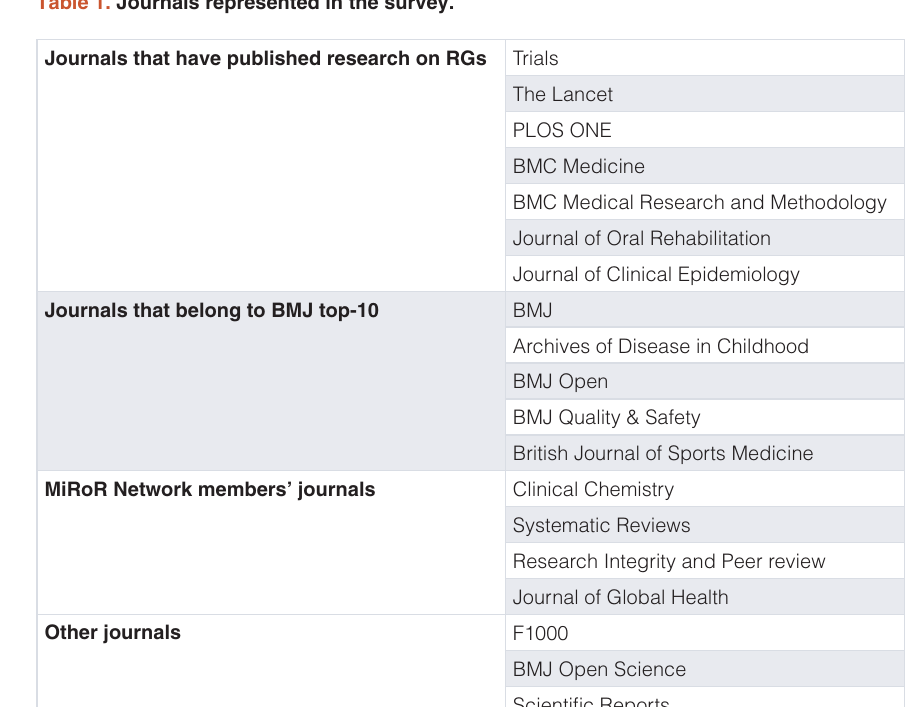
Table 1. Journals represented in the